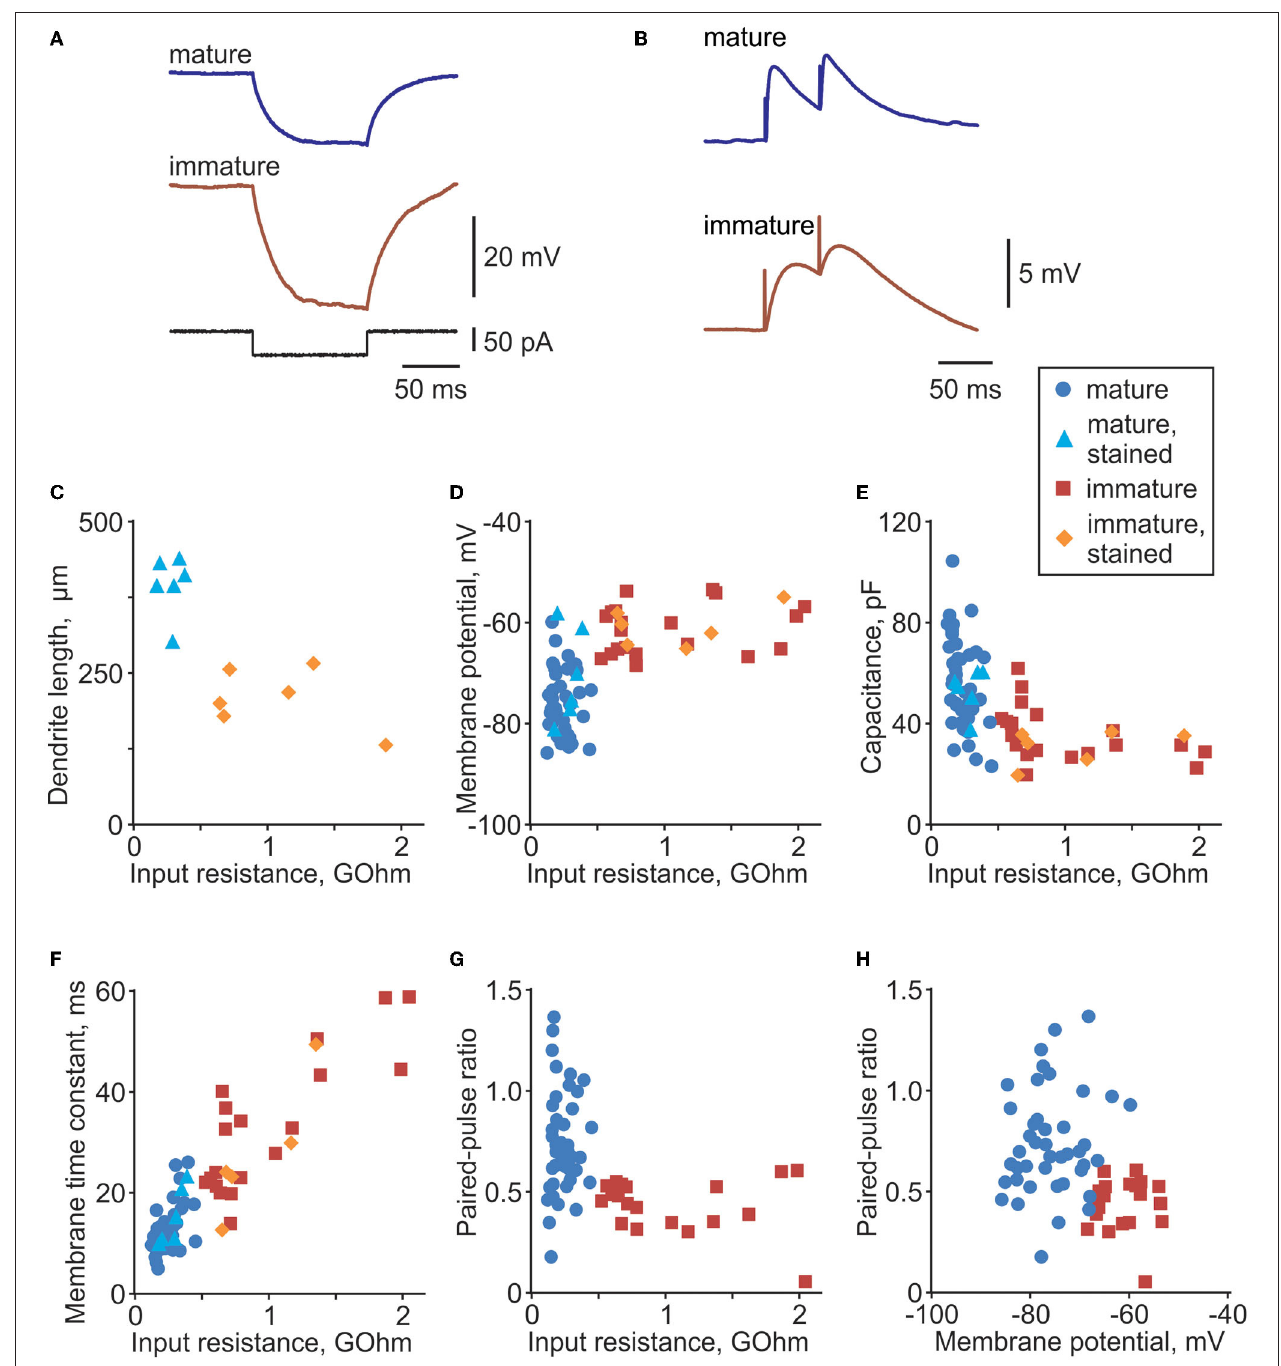
FIGURE 1 | Distinct electrophysiological properties of mature and immature cells in rat dentate gyrus. (A) Membrane potential response to injection of a − 50pA current step in example mature and immature neurons in dentate gyrus. Responses to negative current steps were used to measure input resistance and membrane time constant. (B) Example PSP responses in a mature and an immature neuron evoked by paired-pulse stimulation. (C) Dendrite length (distance between the most distant dendrite and the soma) plotted against input resistance for 6 mature (PSA-NCAM immunonegative, light blue triangle symbols) and 6 immature (PSA-NCAM immunopositive, orange diamond symbols) cells. (D–F) Membrane potential (D) , cell capacitance (E) , and membrane time constant (F) plotted against input resistance for morphologically identified mature ( n = 6, light blue triangle symbols) and immature cells ( n = 6, orange diamond symbols), and electrophysiologically classified mature ( n = 51, blue circle symbols) and immature ( n = 20, dark red square symbols) cells. (G,H) Paired-pulse ratio plotted against input resistance (G) and membrane potential (H) for electrophysiologically classified mature ( n = 51, blue circle symbols) and immature ( n = 20, dark red square symbols) cells.